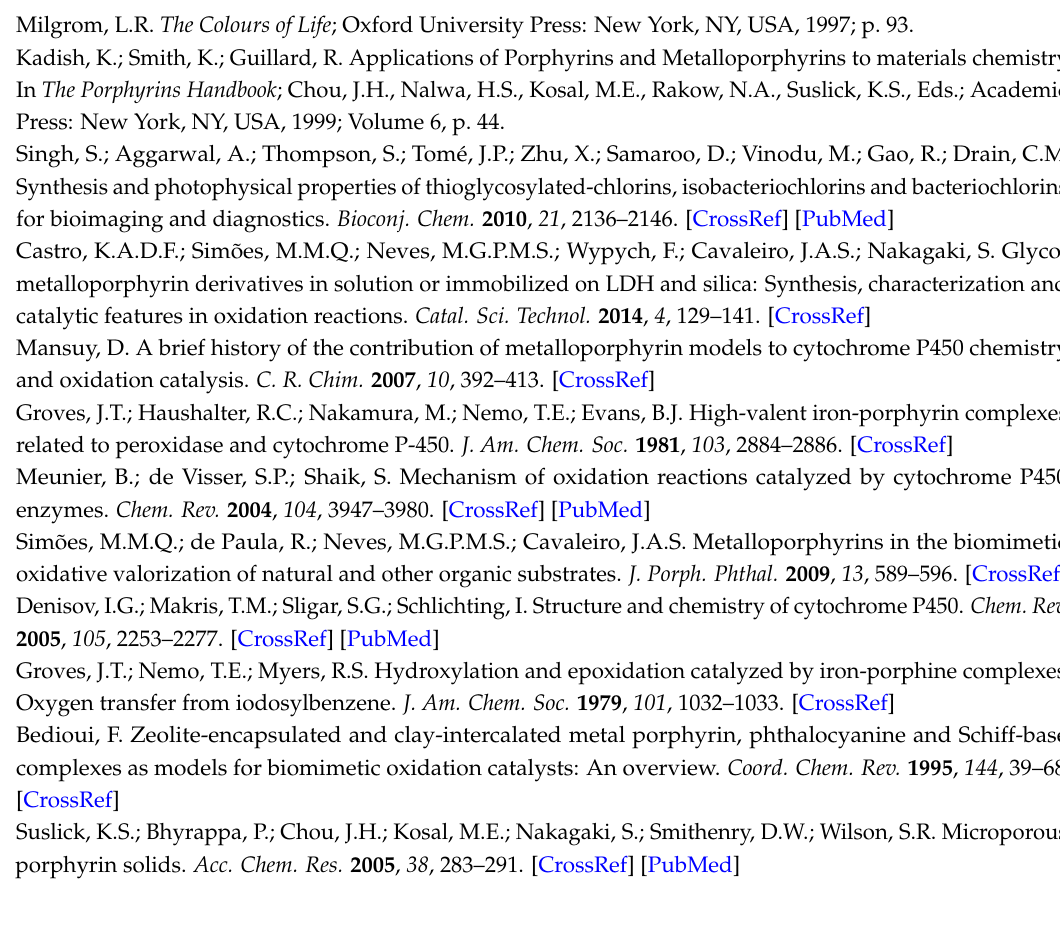
Figure S1: Infrared spectra of the prepared LDHs intercalated with: ( a ) CO 32 ´ ; ( b ) NO 3 ´ .; Figure S2: Thermogravimetric analysis of the synthetized